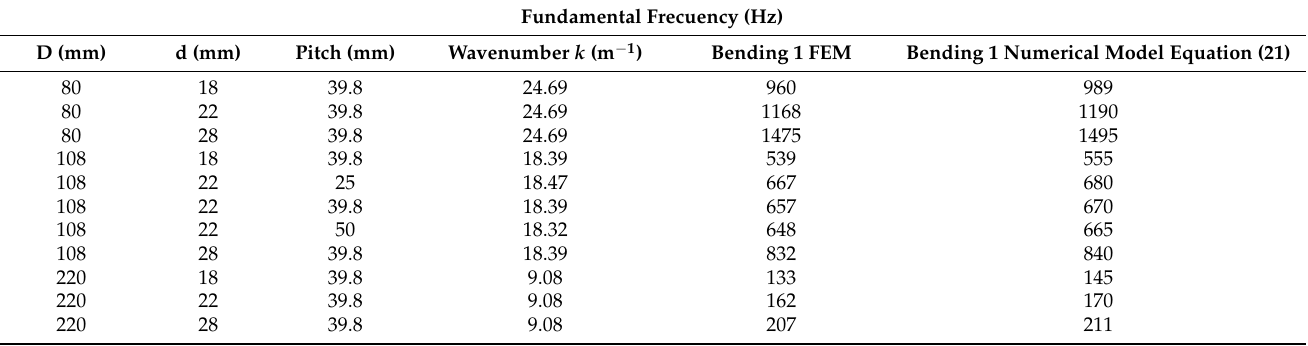
Table 3. Comparison of the numerical model with FEM for the first harmonic